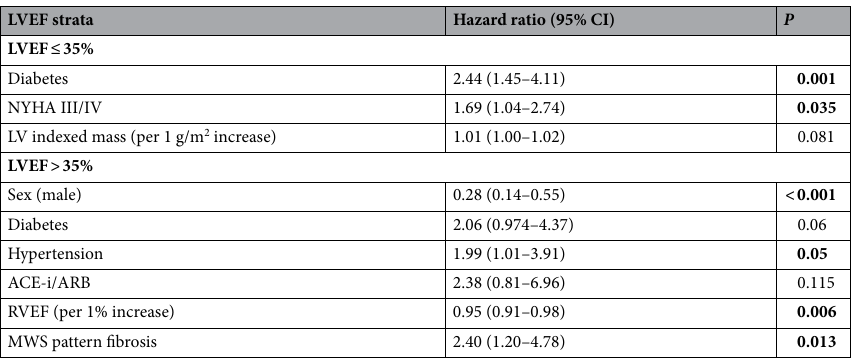
Table 3. Multivariable analysis performed for the prediction of the primary outcome in (1) sub-group of patients with LVEF ≤ 35%, (2) sub-group of patients with LVEF > 35%. Variables included in the stepwise multivariate model include age, sex, body mass index, diabetes, hypertension, NYHA III/IV, ACE-inhibitor/ ARB use, beta-blocker use, LVEF, RVEF, indexed LV mass and MWS fibrosis. NYHA New York heart association, RVEF right ventricular ejection fraction, MWS mid-wall fibrosis. The "bold" means that the p -value is statistically significant at < 0.05.